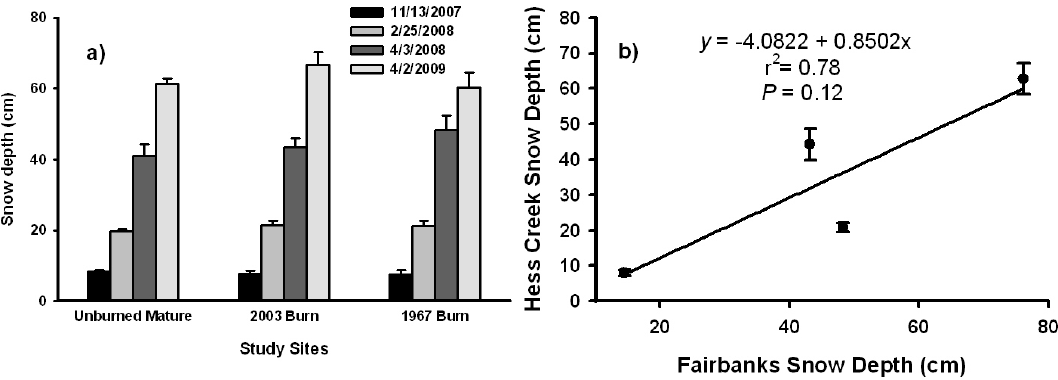
Fig. 2. (a) Results from snow surveys conducted the winter of 2007–2008 and April 2009 at the Hess Creek study sites. (b) Linear curve fit between snow depth measured at Hess Creek and near Fairbanks (data from Bonanza Creek Long-Term Ecological Research Station,